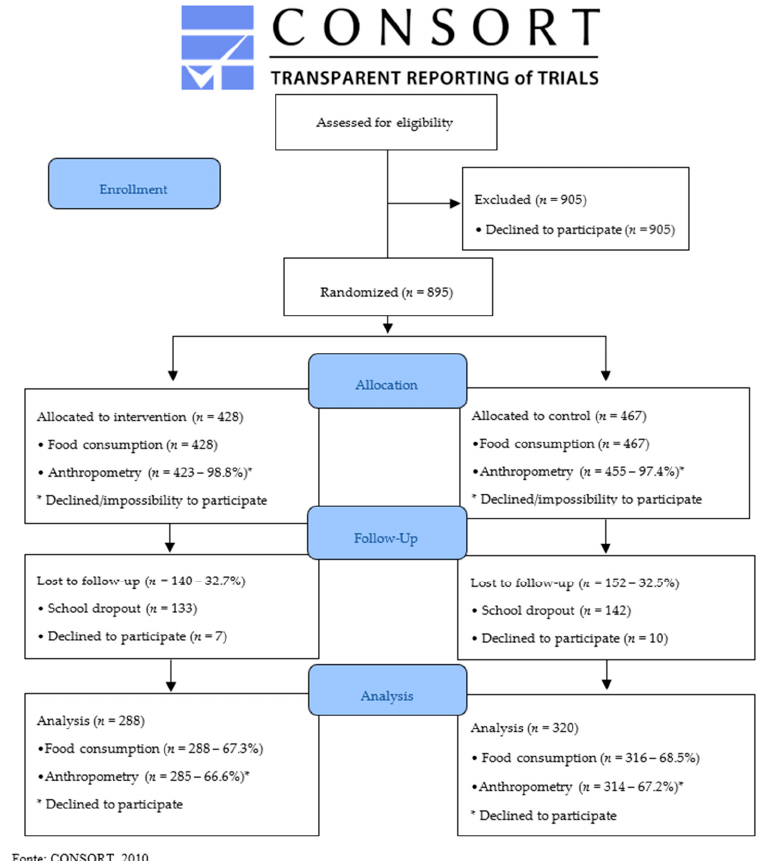
Figure 1. Flowchart of adolescent recruitment and participation in the study.